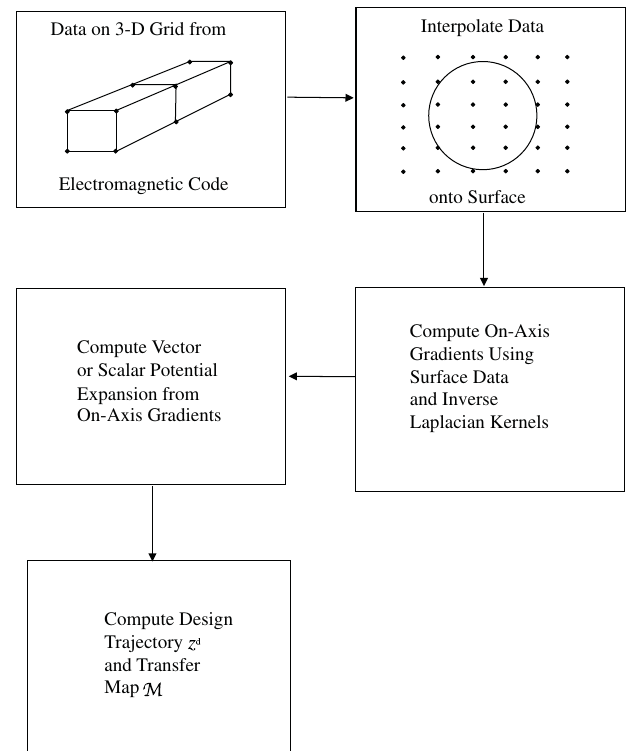
FIG. 2. Calculation of realistic design orbit z d and its associ- ated realistic transfer map M based on data provided on a three- dimensional grid for a real beam-line element. Only a few points on the three-dimensional grid are shown. In this illustration, data from the three-dimensional grid are interpolated onto the surface of a cylinder with circular cross section, and these surface data are then processed to compute the design orbit (trajectory) and the associated transfer map about the design orbit. The use of other surfaces is also possible, and may offer various